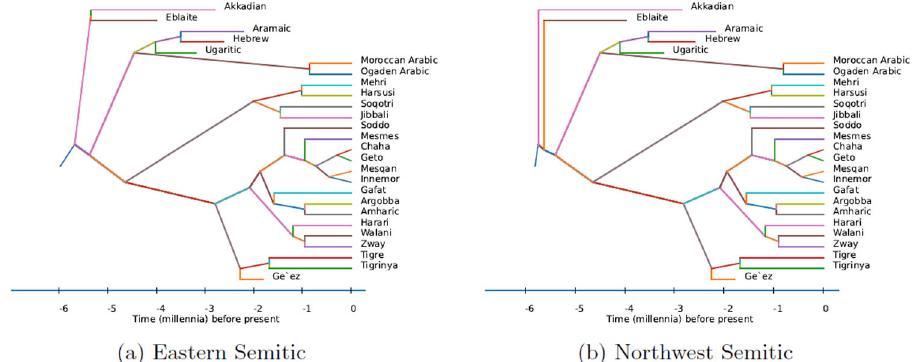
Fig. 10 Two alternatives for the inclusion of Eblaite in the Semitic language tree. The left-hand side of the fi gure modi fi es the Semitic language tree to include Eblaite and Akkadian together as part of an Eastern Semitic branch of the Semitic Tree ( a ), while the righthand side shows Eblaite branching off from Akkadian as part of a continuing expansion ( b ).